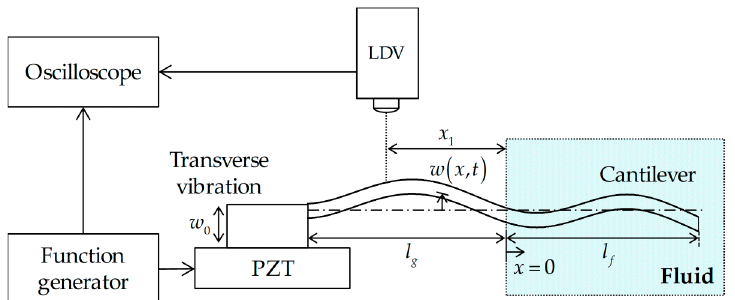
Figure 1. A schematic of the experimental setup, which consists of a micro-cantilever partially immersed in a fluid, a single-point laser Doppler vibrometer (LDV), a function generator, and a lead zirconate titanate (PZT). The vibration velocity of the cantilever was measured at x = − x 1 via the LDV. The figure shows standing wave patterns of the partially immersed cantilever in the fluid at the fourth resonance frequency.